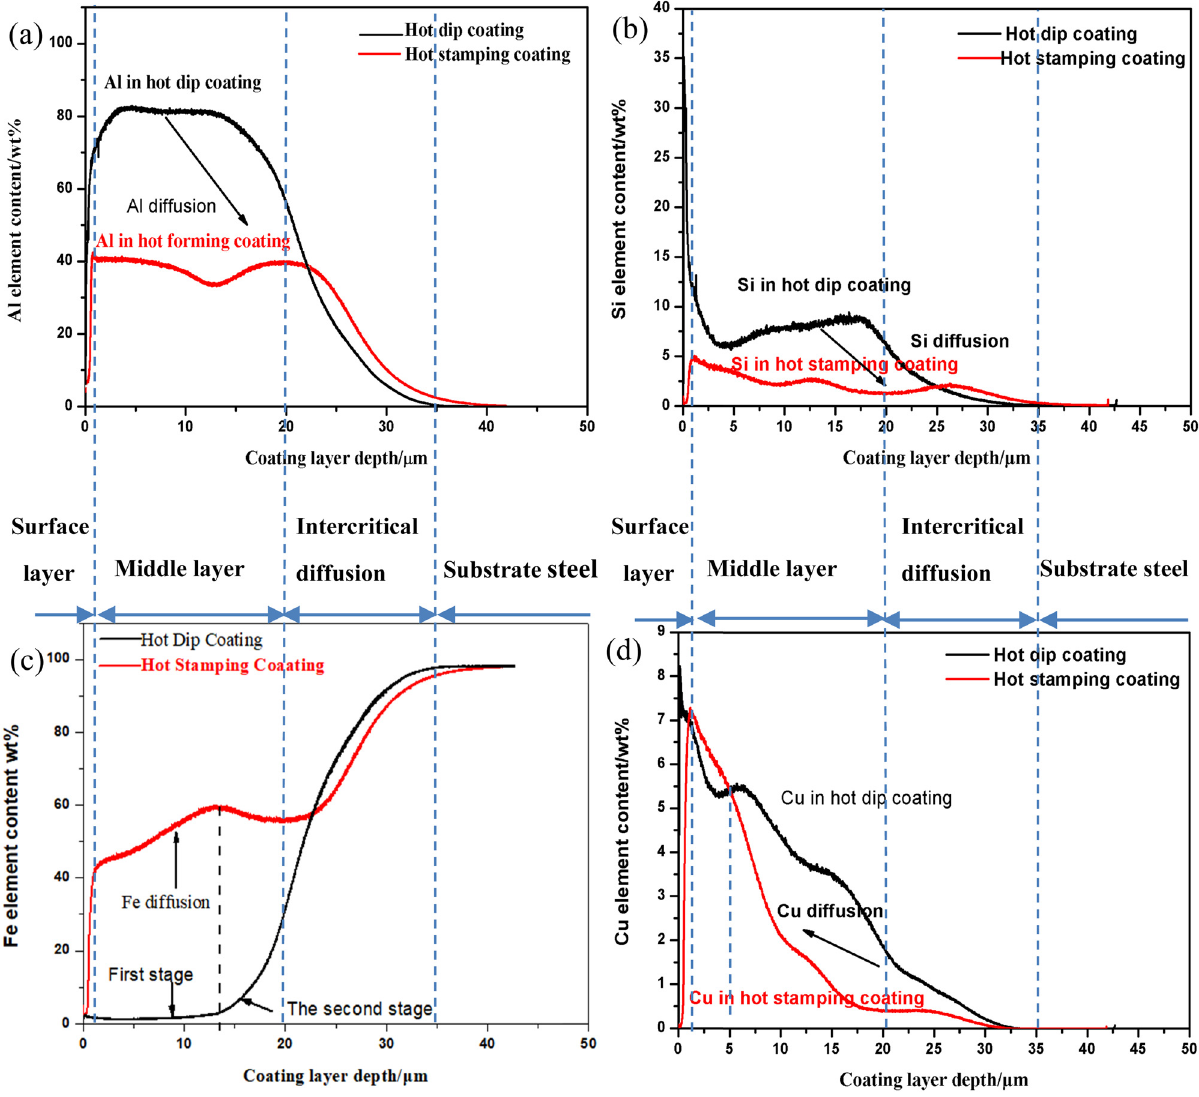
Figure 8: Element distribution in hot - dip and hot stamping coatings with the heating temperature of 850°C: ( a ) Al, ( b ) Si, ( c ) Fe, and ( d )